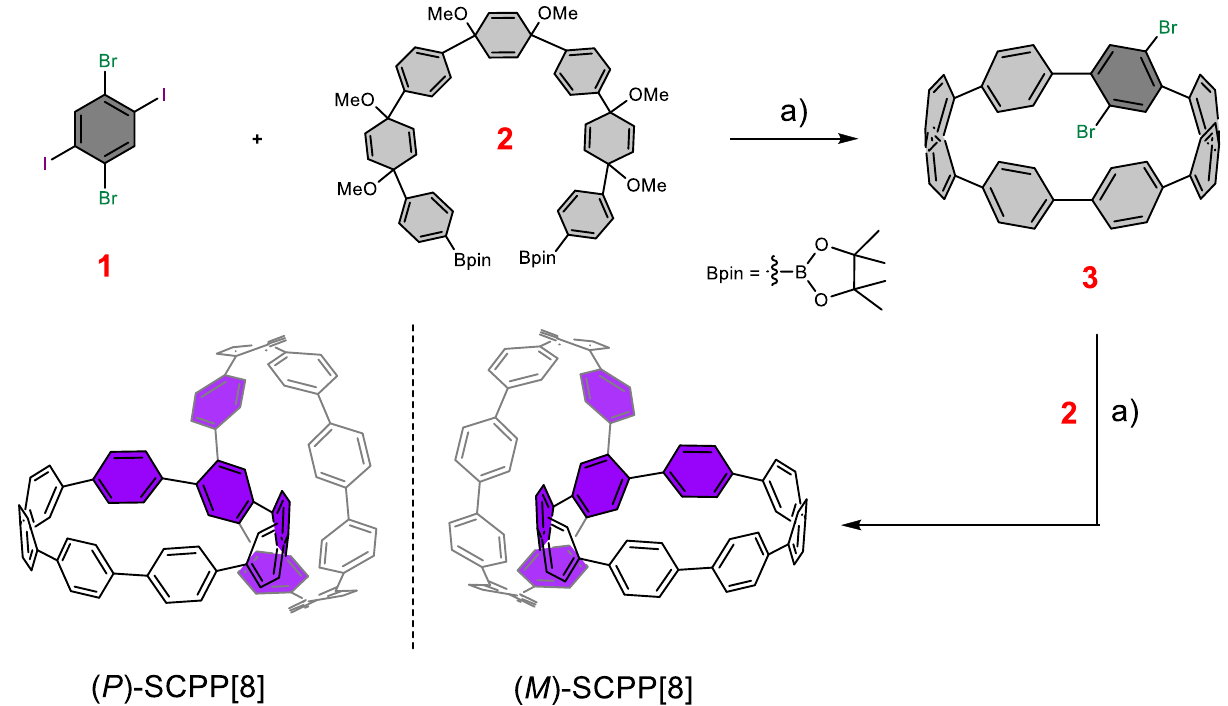
Fig. 2 Design and synthesis procedure for inherently chiral SCPP[8] with 1,2,4,5-TPB core. Reagents and conditions: a (i) Pd(PPh 3 ) 4 , KOH, THF/H 2 O, 2 days at 73 °C; (ii) H 2 SnCl 4 , THF, RT.